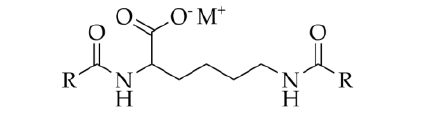
Figure 1. The molecular structure of N α , N ε -diacyl- L -lysine derivatives studied in the current study.